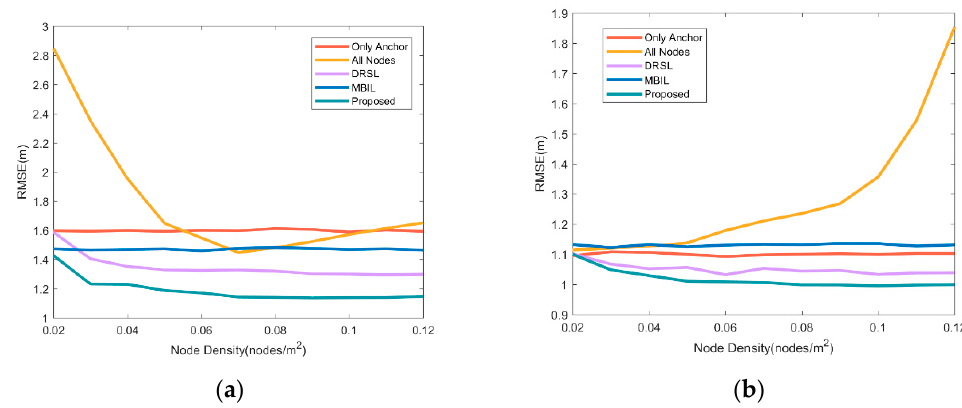
Figure 5. Comparison of positioning accuracy of various source selection methods under different node densities. ( a ) is the comparison when the average number of anchor node connections is 3. ( b ) is the comparison when the average number of anchor node connections is 10. The red line represents the non-cooperative localization using only anchor nodes, the orange represents the cooperative localization using all neighbor nodes as the source, the purple line represents the DRSL source selection location algorithm proposed in [30] , the blue line represents the MBIL algorithm in [23] and the green line represents the source optimization algorithm proposed in this article for cooperative localization.